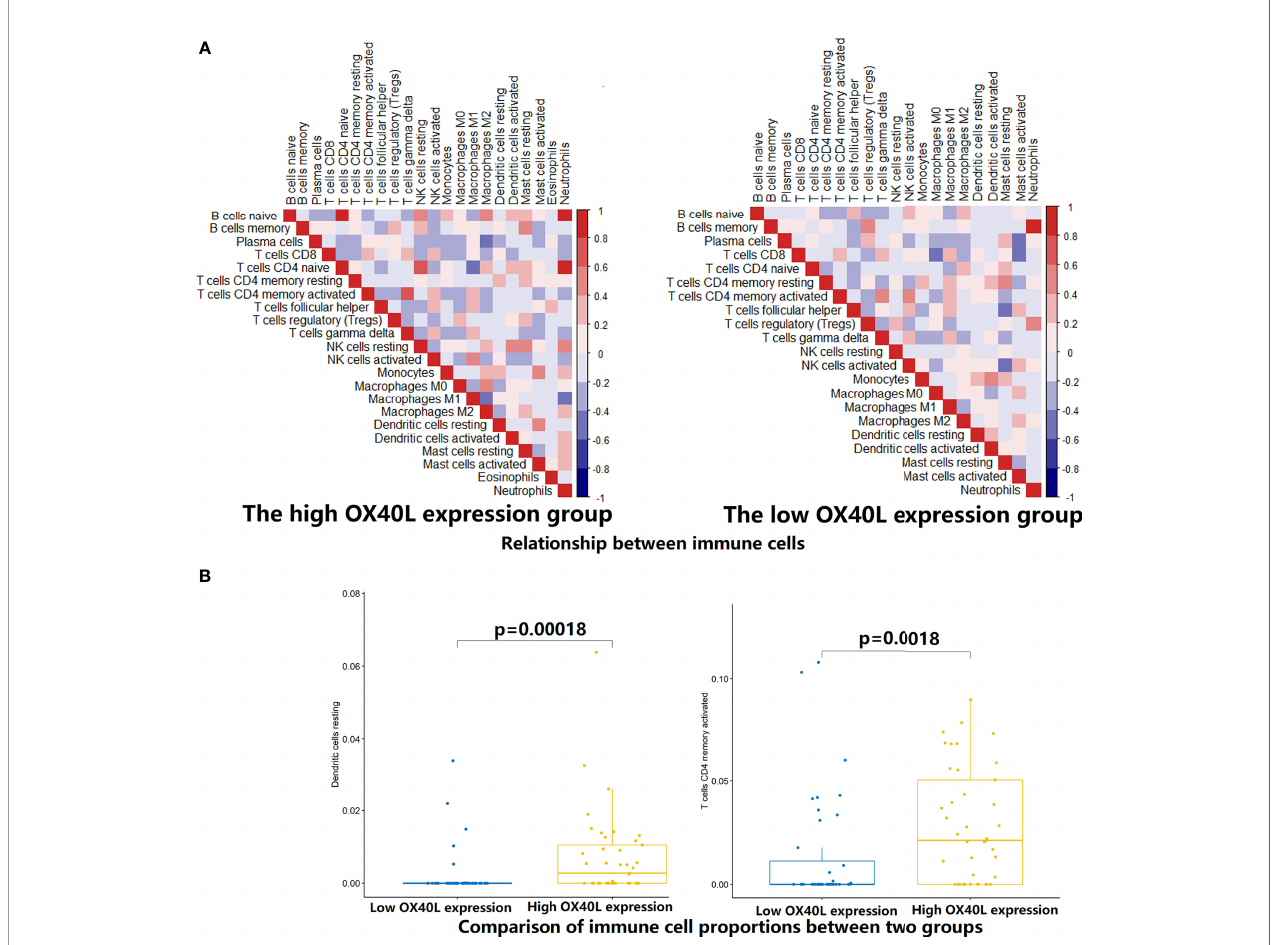
FIGURE 7 | Estimation of relative in fi ltration proportions of 22 kinds of immune cells in the high and low OX40 ligand (OX40L) expression group. (A) By the CIBERSORTx algorithm, relationship matrixes of 22 immune cells in small cell lung cancer patients with high and low OX40L expression. (B) The in fi ltration of resting dendritic cells (p=O.OOO18) and activated memory CD4+ T cells (p=0.0018) was elevated in the hi OX40L